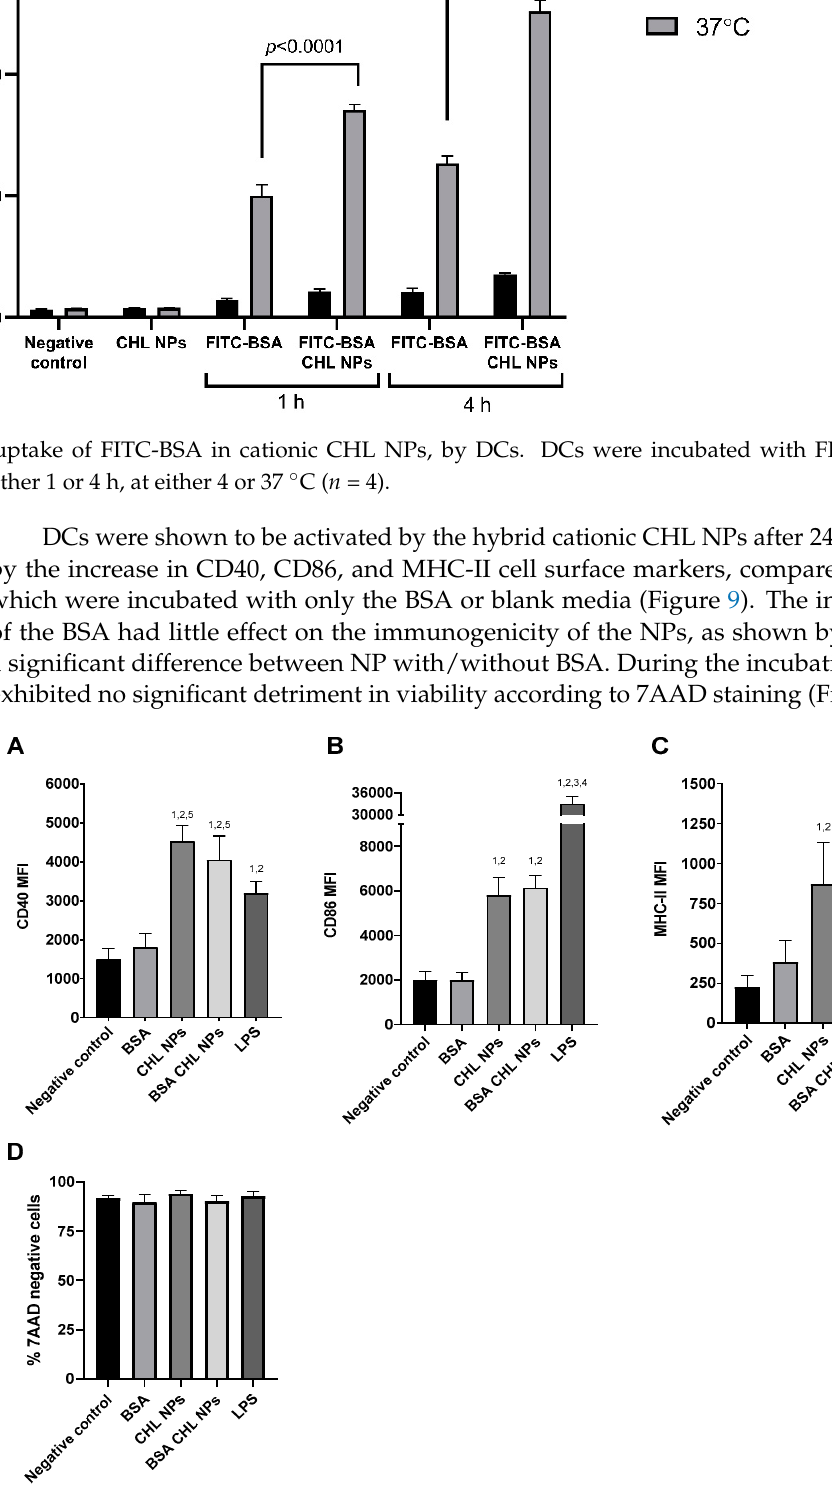
Figure 7. Confocal microscopy images of hybrid cationic CHL NPs uptake by DCs after 1 h incubation. DCs incubated without hybrid cationic CHL NPs at 20× ( A ), DCs incubated with hybrid cationic CHL NPs at 63× ( B ). Red channel for WGA TR: cell membrane, blue channel for DAPI: nucleus, and green channel for FITC-BSA: hybrid cationic CHL NPs incorporating FITC-BSA.